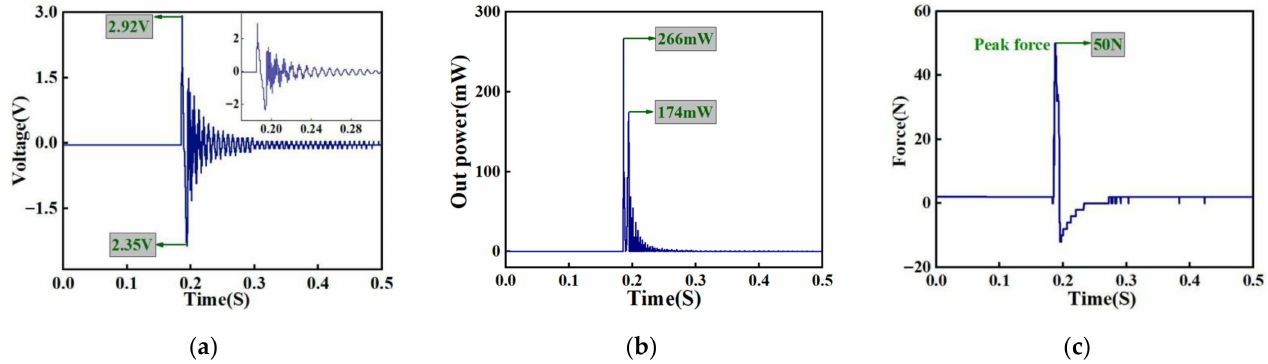
Figure 22. Output performance of the double-stage rhombus energy harvesting device under transient excitation. ( a ) output voltage; ( b ) Output power; ( c ) Force input signal.